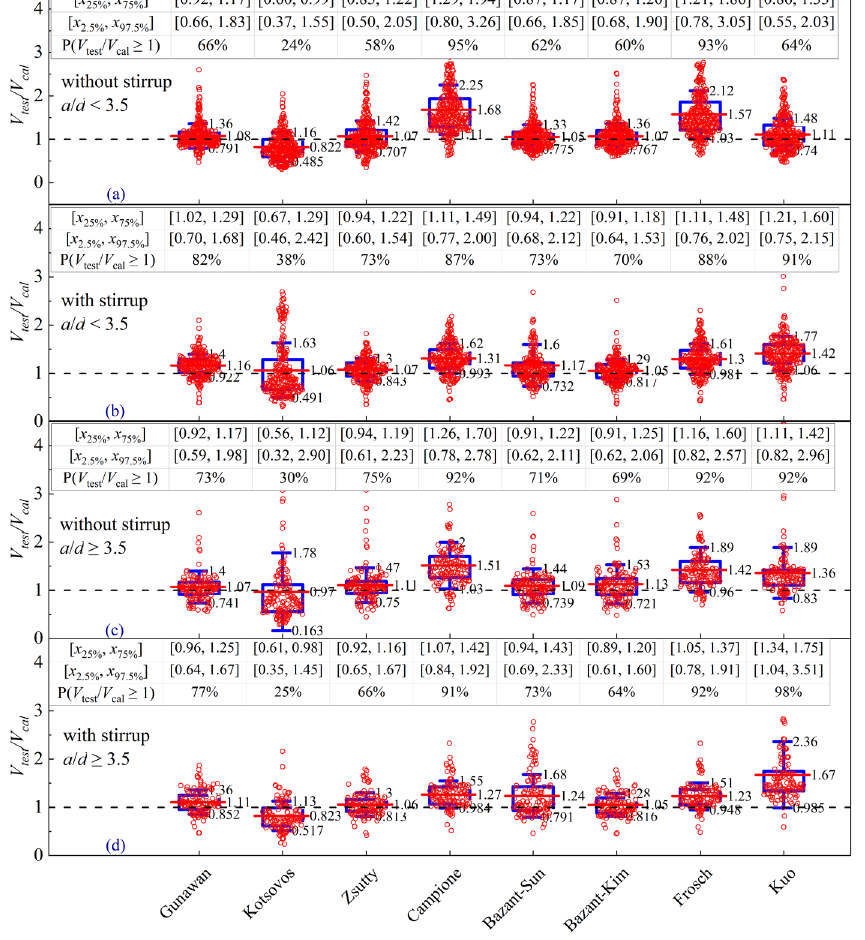
Figure 8. Researchers: prediction results for beams without stirrup versus ( a ) a / d < 3.5; ( c ) a / d ≥ 3.5 and for beams with stirrup versus ( b ) a / d < 3.5; ( d ) a / d ≥ 3.5.